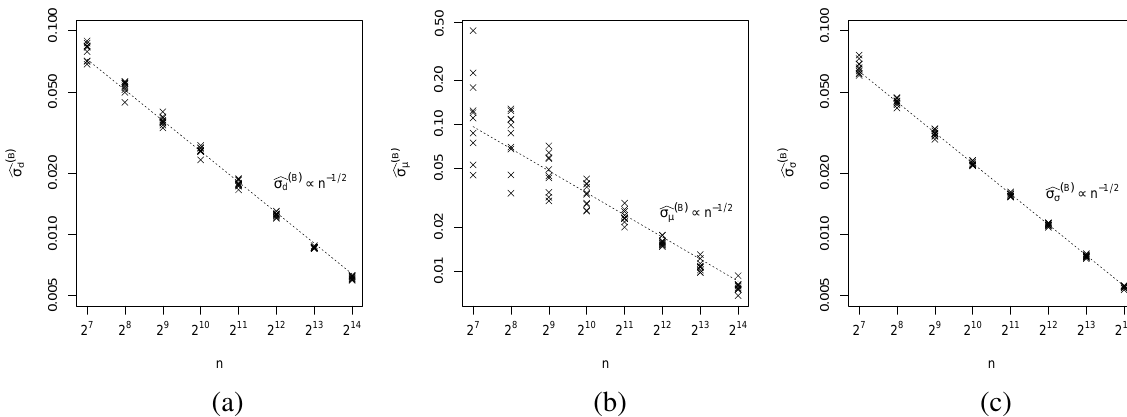
Figure 3. Posterior outputs from an ARFIMA(0,0,0) series: (a) the posterior standard deviation in d , b σ d ( B ) against the sample size n ; (b) posterior standard deviation in µ , c σ µ( B ) against n ; and (c) c σ σ( B ) against n (log–log scale).